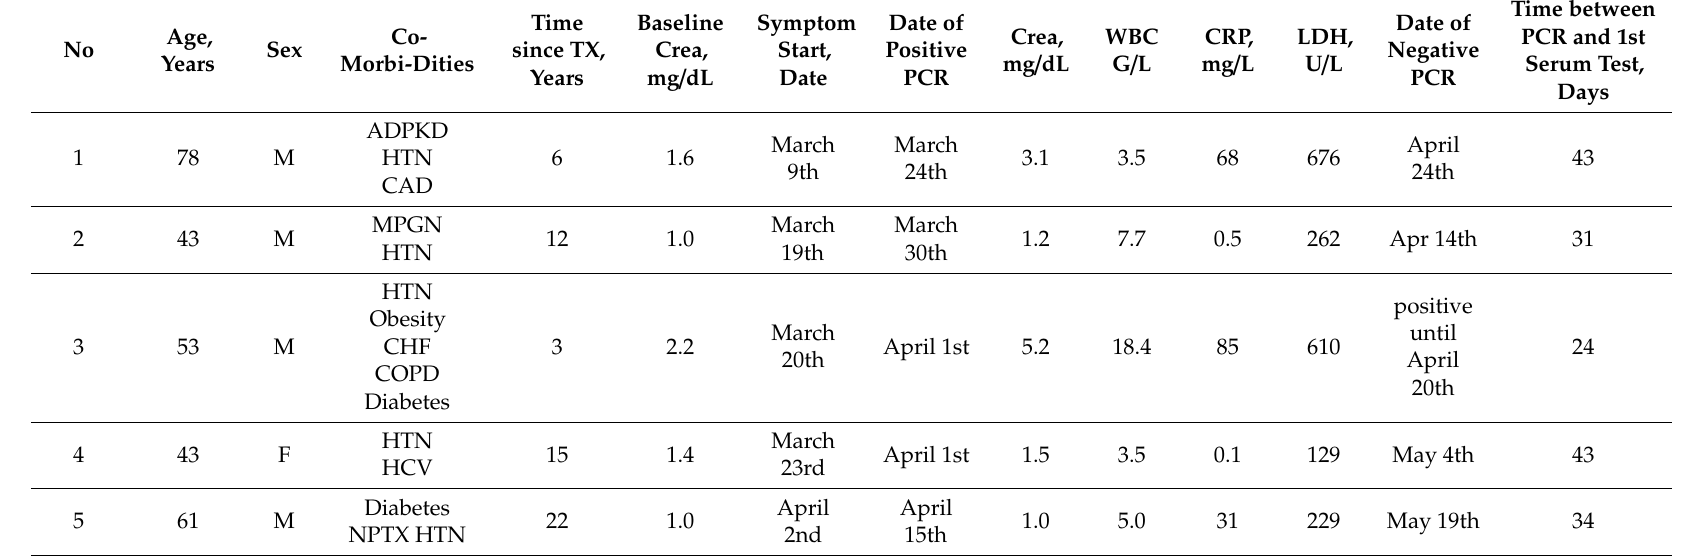
Table 2. The characteristics of five renal transplant recipient patients who experienced PCR-confirmed